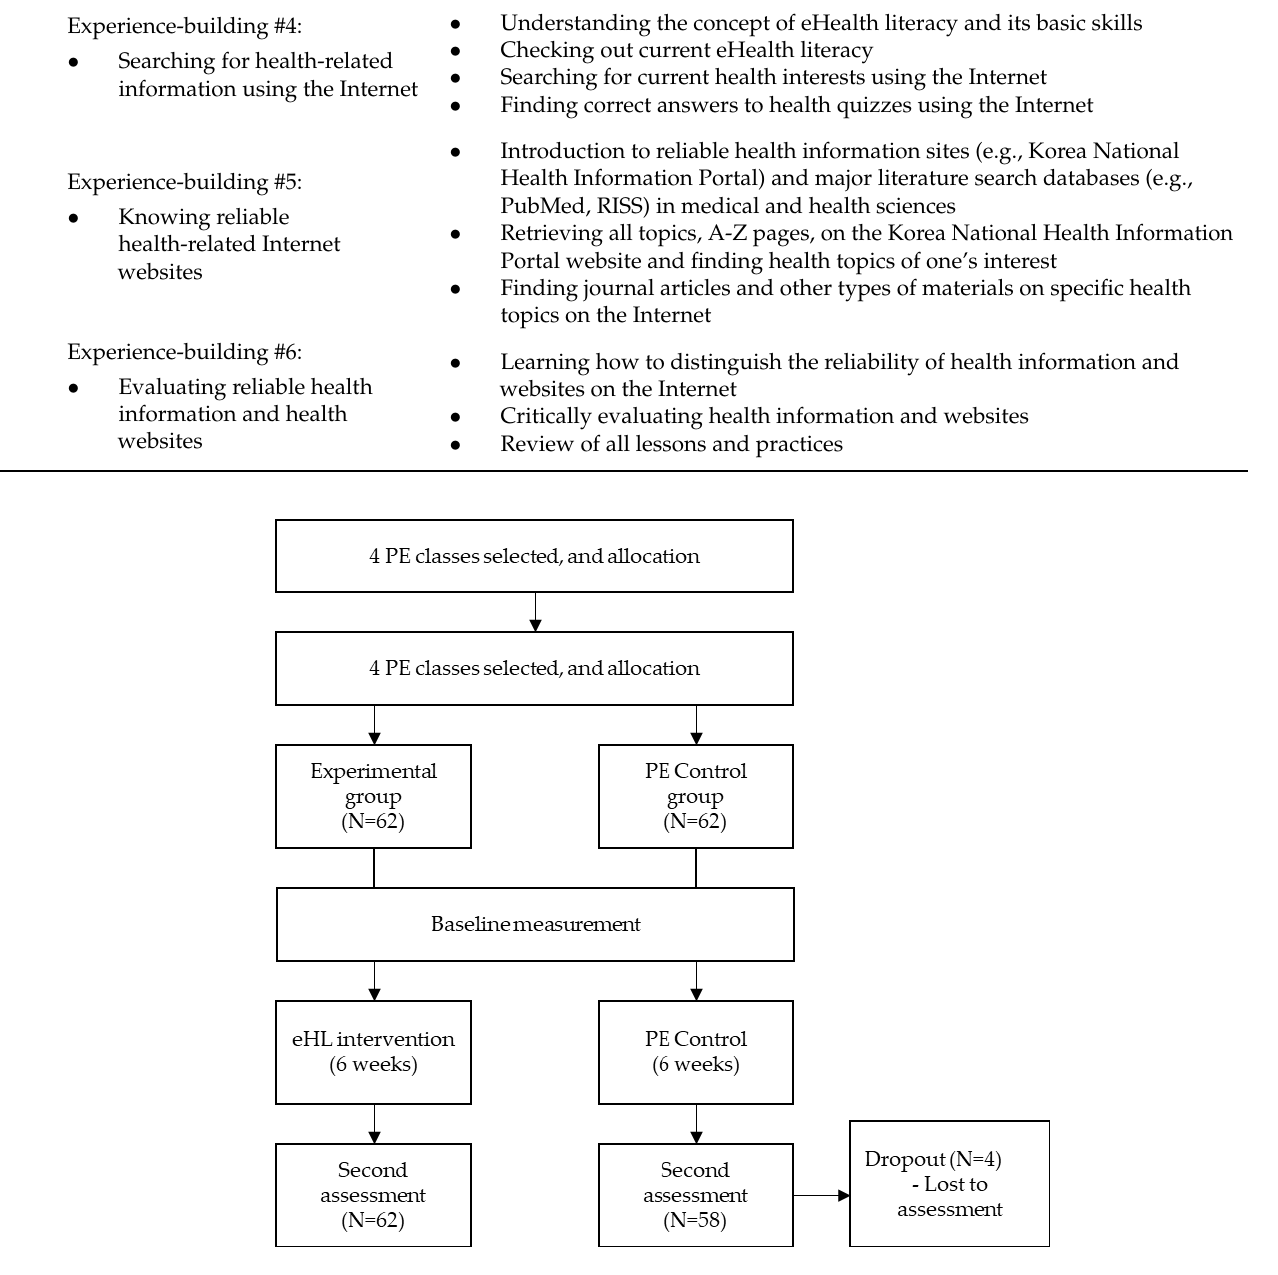
Figure 1. Participant enrollment and assessment flowchart. PE: Physical Education; eHL: eHealth